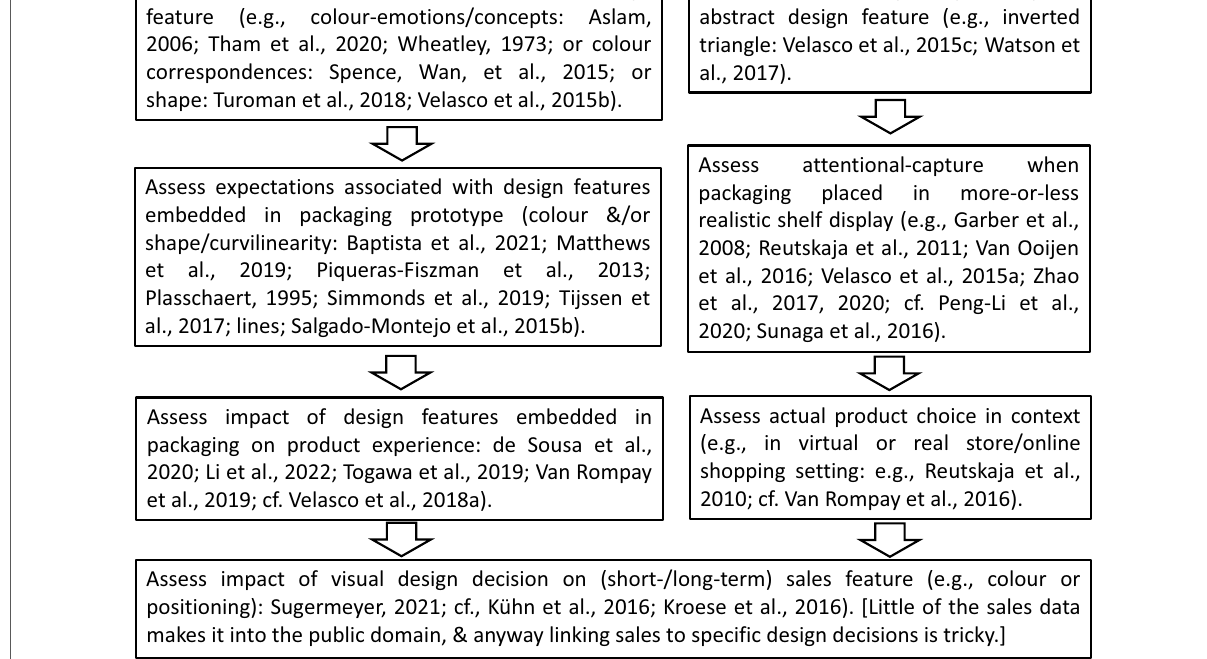
Fig. 2 Assessment of visual design choices regarding specific individual design features (e.g. use of a particular colour or shape) at various stages of the packaging (design)